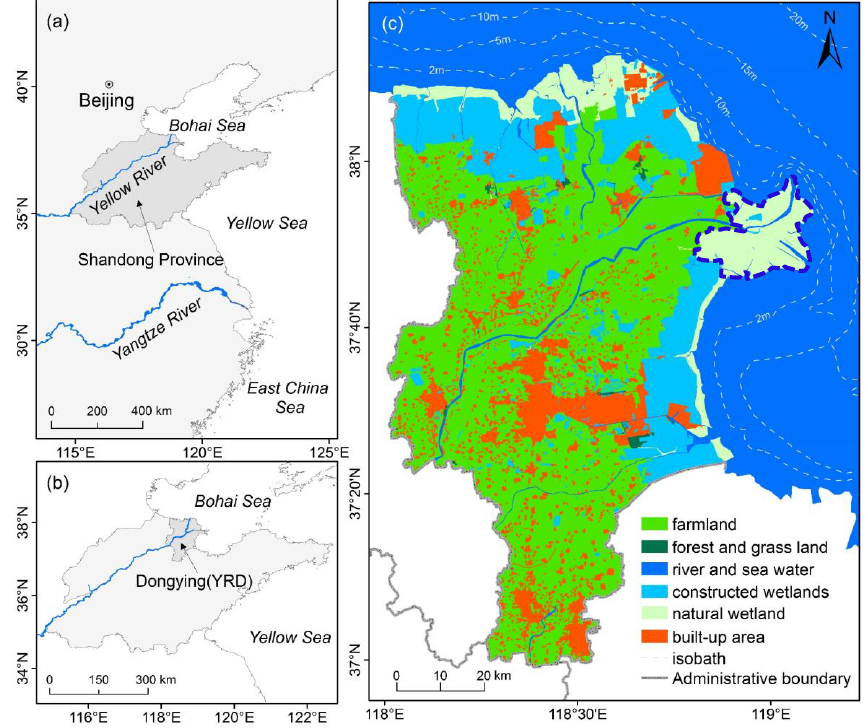
Figure 1. ( a , b ) Geographic location of the Yellow River Delta (YRD). ( c ) Land use in the YRD, and the active estuarine area is circled by the blue dotted line.